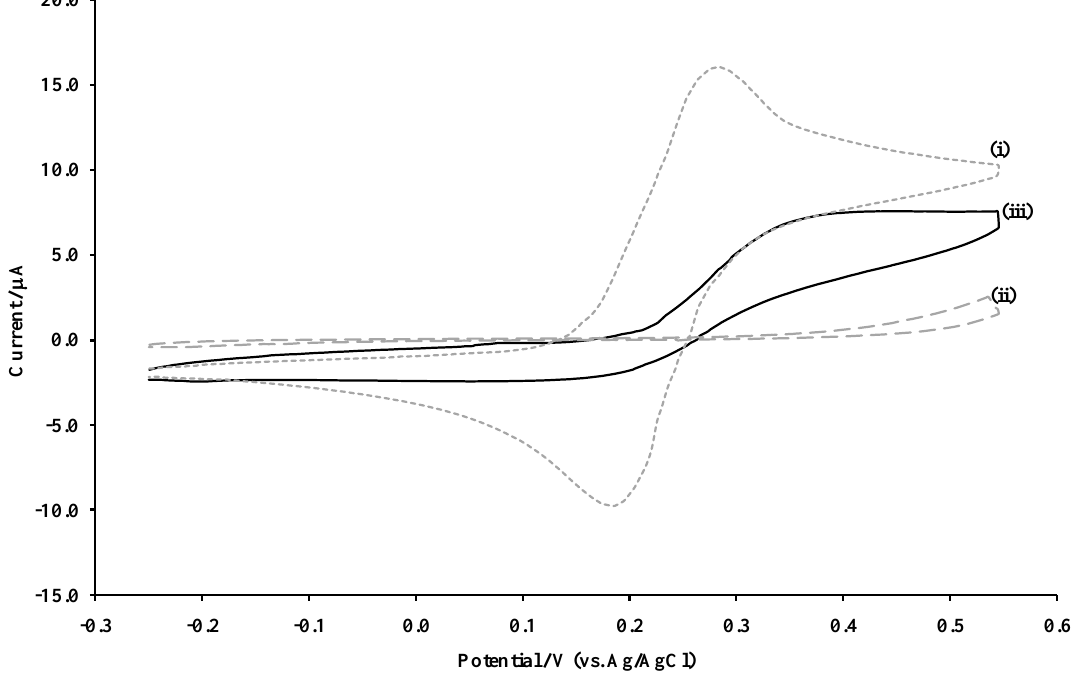
Figure 5. Cyclic voltammetry of 1 mM ferrocenemonocarboxylic acid, at (i) a bare carbon electrode, (ii) a P o PDA coated carbon electrode and (iii) a similar electrode subsequently sonicated for 20 seconds. [Supporting electrolyte: phosphate buffer (0.1 M, pH 7.4). Scan rate: 20 mVs –1